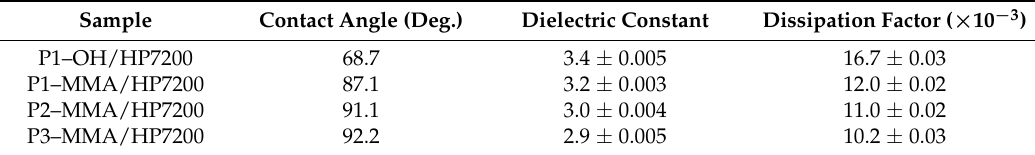
Table 3. Contact angle and dielectric properties of prepared polymers. Sample Contact Angle